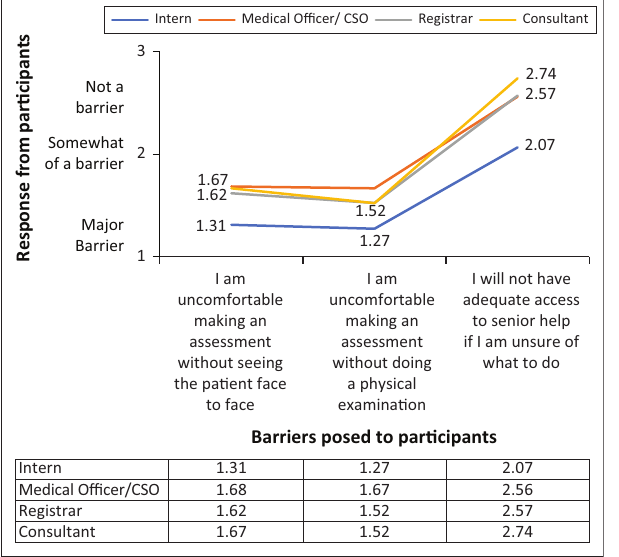
FIGURE 2 : Responses showing significant difference between interns versus all other groups.